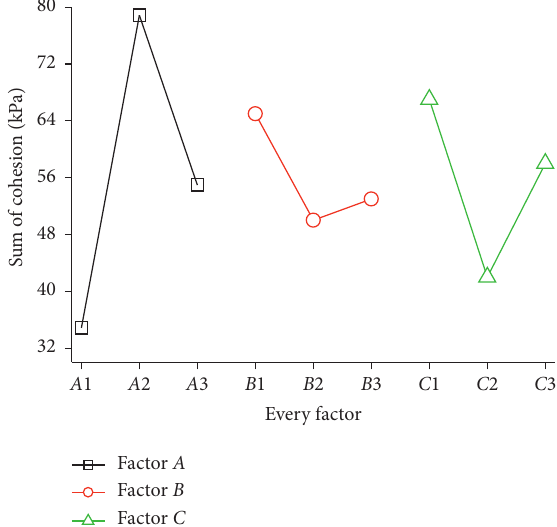
Figure 2: Cohesive force of trend